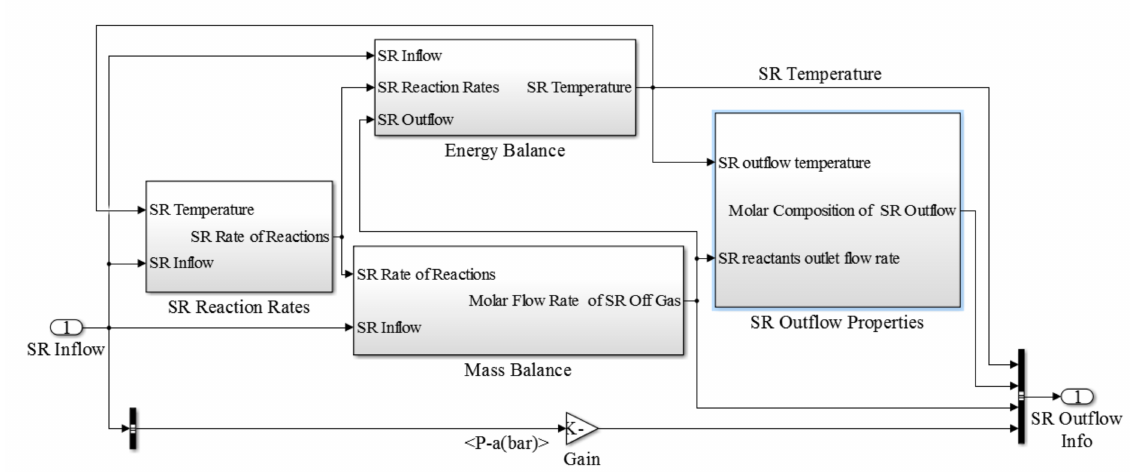
Figure 4. Block diagram of the steam reformer